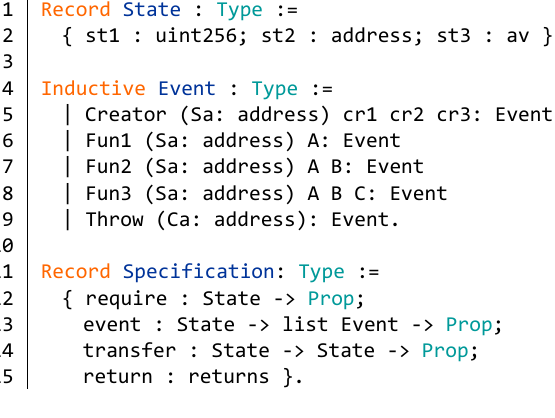
Figure 8. Abstract structure of function